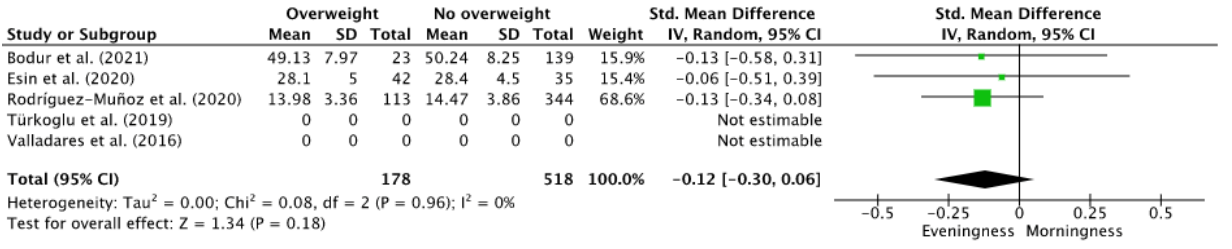
Figure 2. Forest plot of the relationship between chronotype and overweight/obesity.